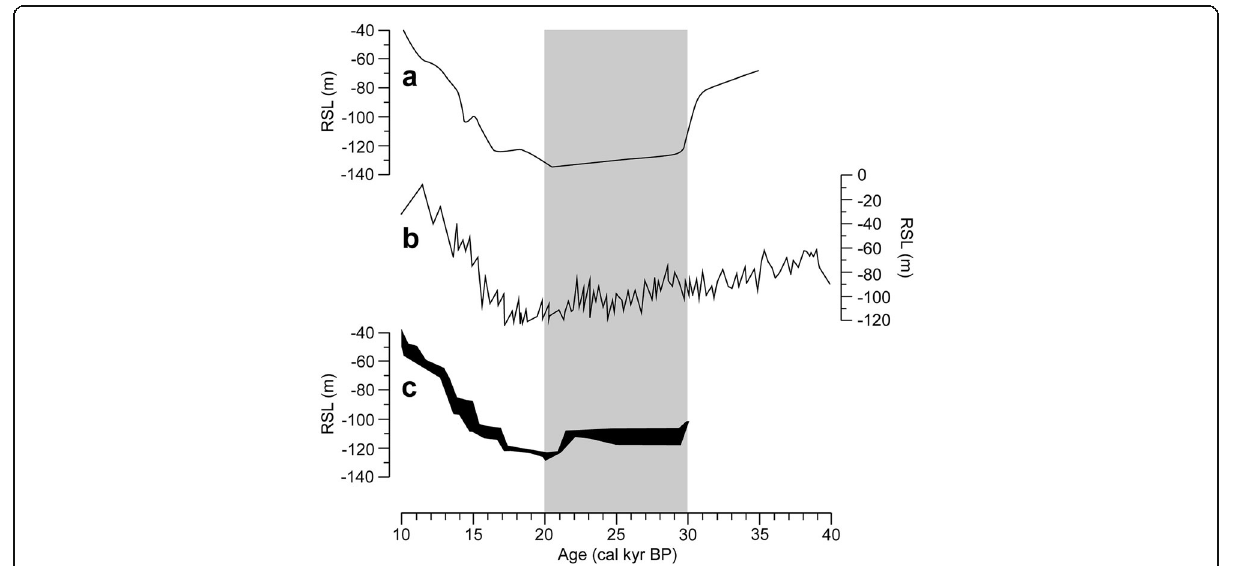
Fig. 11 Sea-level change during the period of formation of the BG. Sea-level curves ( a ), ( b ), and ( c ) are after Lambeck et al. (2014), Siddall et al. (2003), and Yokoyama et al. (2018), respectively. The gray shaded area marks the period of formation of the BG. RSL relative